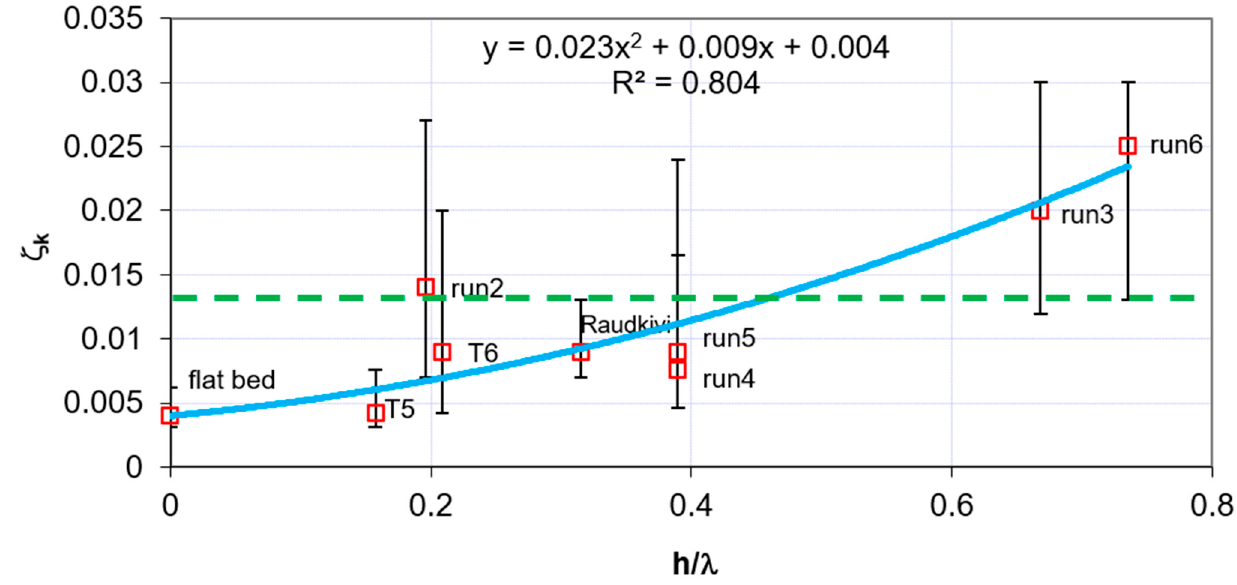
Figure 9. Calibration coefficient for the MDAKE model. The upper limit of each bar gives at most 25% over-prediction of k max whereas the lower limit gives at most 20% under-prediction of k max . In Figure 9, three values of ξ k are presented for each experiment: the medium value, It should also be mentioned that the ratio of h / λ for fully developed bedforms is expected to be less than 0.4. This might suggest using a calibration coefficient that best fit only the experiments within this range. According to Figure 9, a value of ( ζ k = 0.075) might be more